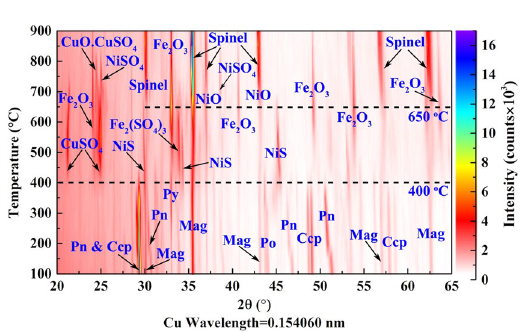
Figure 2. Predominance area diagram for the Ni 4.5 Fe 4.5 S 8 –CuFeS 2 –SO 2 –O 2 system in the temperature range of 450 to 900 °C in air (p(O 2 ) = 0.21 atm).